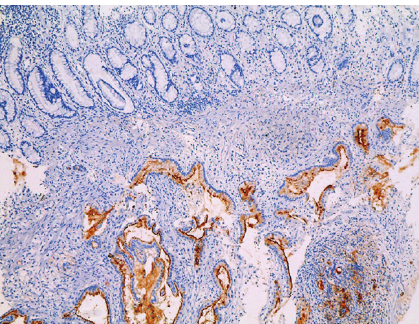
Figure 3: IHC staining of rectal biopsy taken during colonoscopy.